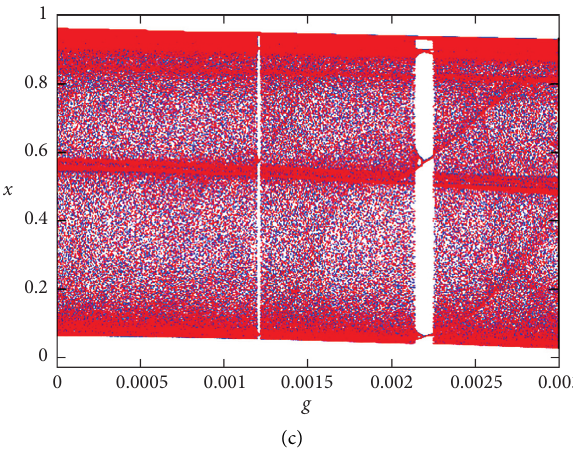
Figure 13: Effect of parameter α on bifurcation diagram of nonlinear chemical reaction with Ω � ω � 0.0481, f � 0.002, and β � 0.04: (a) α � 0.03; (b) α � 0.028; (c) α � 0.02. Bifurcation diagrams and its corresponding Lyapunov exponent are obtained by scanning the parameter g upwards (blue) and downwards (red).